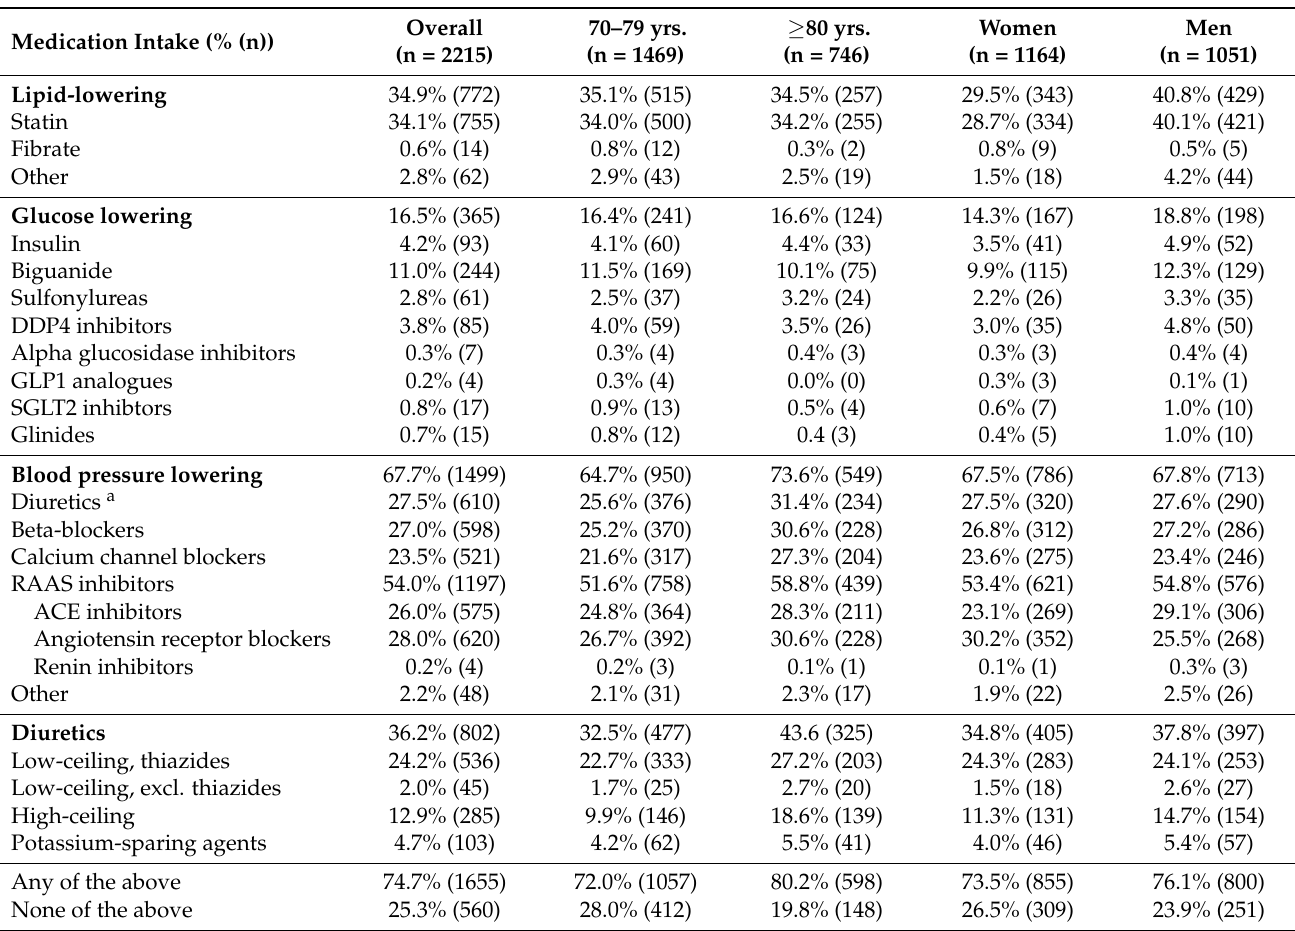
Table 2. Medication intake. Shown is medication intake of AugUR participants grouped by ATC coding. Frequencies are reported as proportion (%, relative to sample size n = 2215) and numbers, as well as stratified by age group and